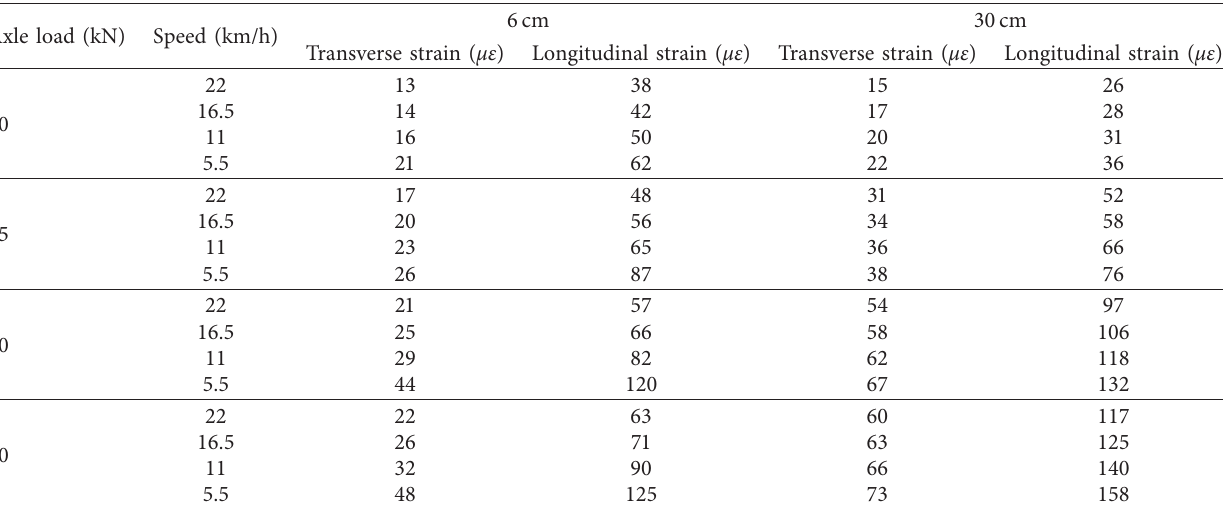
Table 6: Strains of flexible pavement at different axle loads.